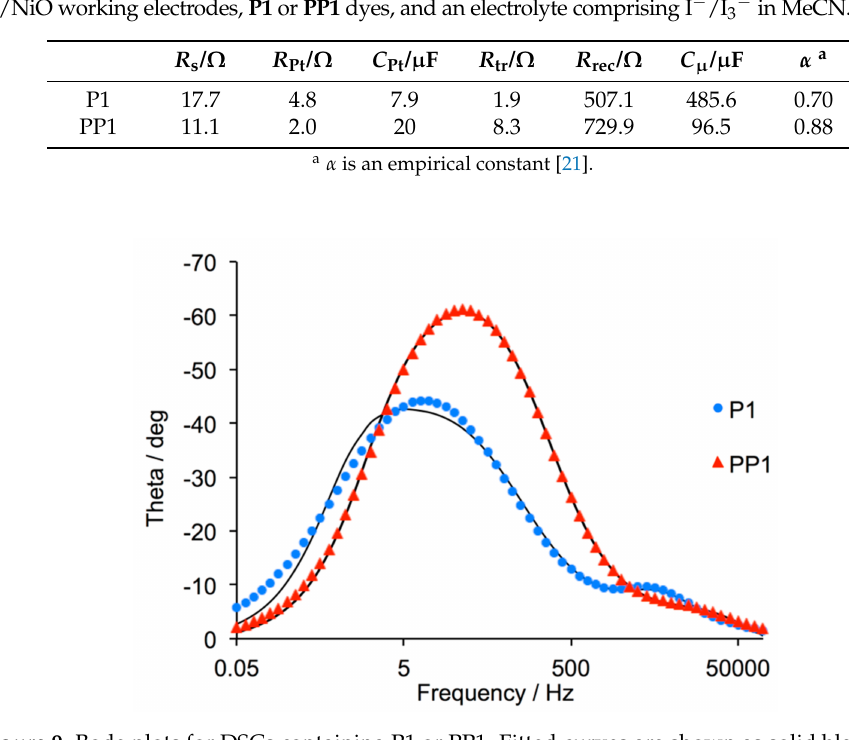
Figure 9. Bode plots for DSCs containing P1 or PP1. Fitted curves are shown as solid black